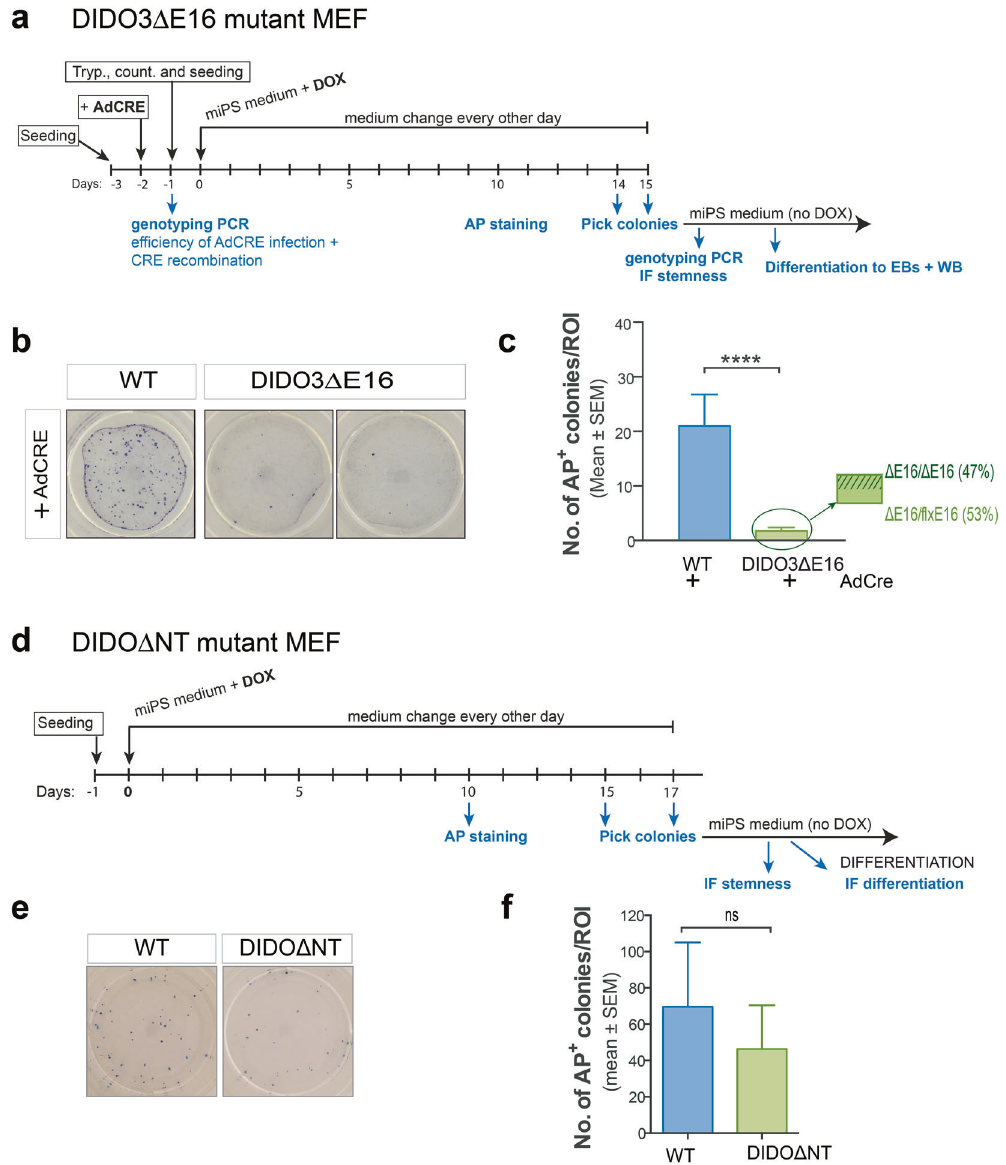
phosphatase staining. b Image of representative wells after staining for AP-positive colonies as a pluripotency marker following reprogramming of WT and DIDO3 Δ E16 MEF after AdCre infection. c Quanti fi cation of reprogramming ability of DIDO3 Δ E16/4F-MEF versus WT/4F-MEF after AdCre infection, as determined by AP-positive colonies. DIDO3 Δ E16, n = 8; WT n = 8; bars indicate mean ± SEM. Statistical analysis was performed with two-tailed Student ’ s t -test, **** P < 0.0001. Percentage of genotypes in iPS homozygous for DIDO3 Δ E16/DIDO3 Δ E16 or heterozygous for DIDO3 Δ E16/DIDO3 fl oxedE16 was determined by PCR. d Scheme of experimental onset and DIDO Δ NT/4F-MEF reprogramming procedures. e Staining for AP-positive colonies as a pluripotency marker after WT and DIDO Δ NT MEF reprogramming. f Quanti fi cation as in ( c ) for DIDO Δ NT/4F-MEF ( n = 3) and WT/4F-MEF ( n = 3); bars represent mean ± SEM. Statistical analysis was performed with two-tailed Student ’ s t -test and showed no signi fi cant differences